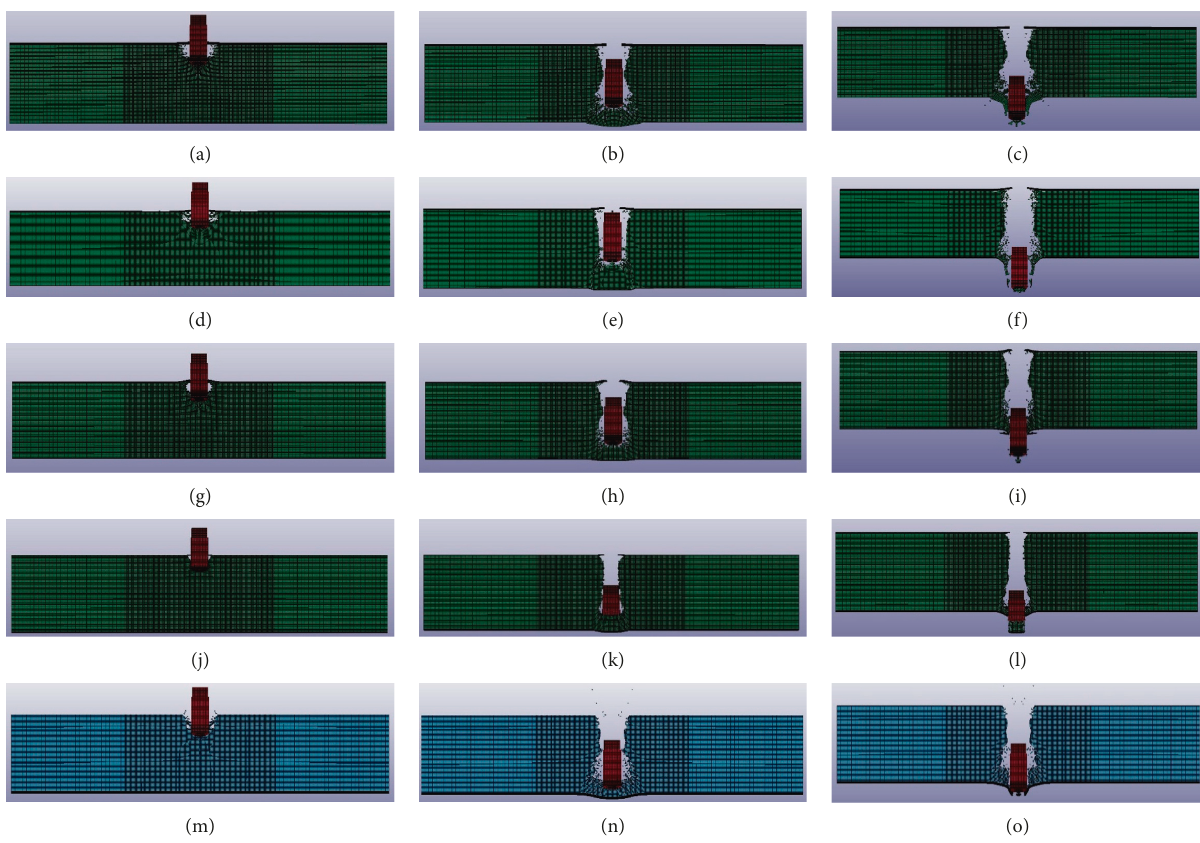
Figure 15: Perforation process of concrete targets with different steel liner layouts (1/2): (a) 108 μ s (3-0); (b) 450 μ s (3-0); (c) 900 μ s (3-0); (d) 90 μ s (2-1); (e) 540 μ s (2-1). Perforation process of concrete targets with different steel liner layouts (2/2): (f) 912 μ s (2-1); (g) 96 μ s (1.5-1.5); (h) 456 μ s (1.5-1.5); (i) 900 μ s (1.5-1.5); (j) 96 μ s (1-2); (k) 480 μ s (1-2); (l) 912 μ s (1-2); (m) 100 μ s (0-3); (n) 720 μ s (0-3); (o) 972 μ s (0-3).